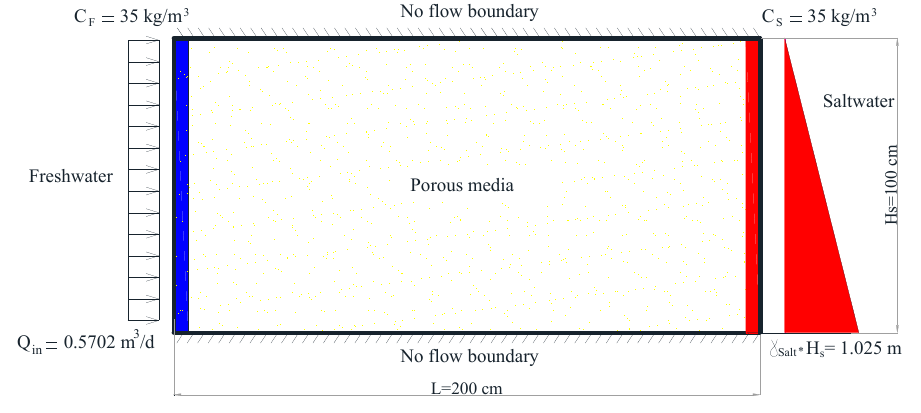
Figure 1. Boundary conditions of Henry’s problem.